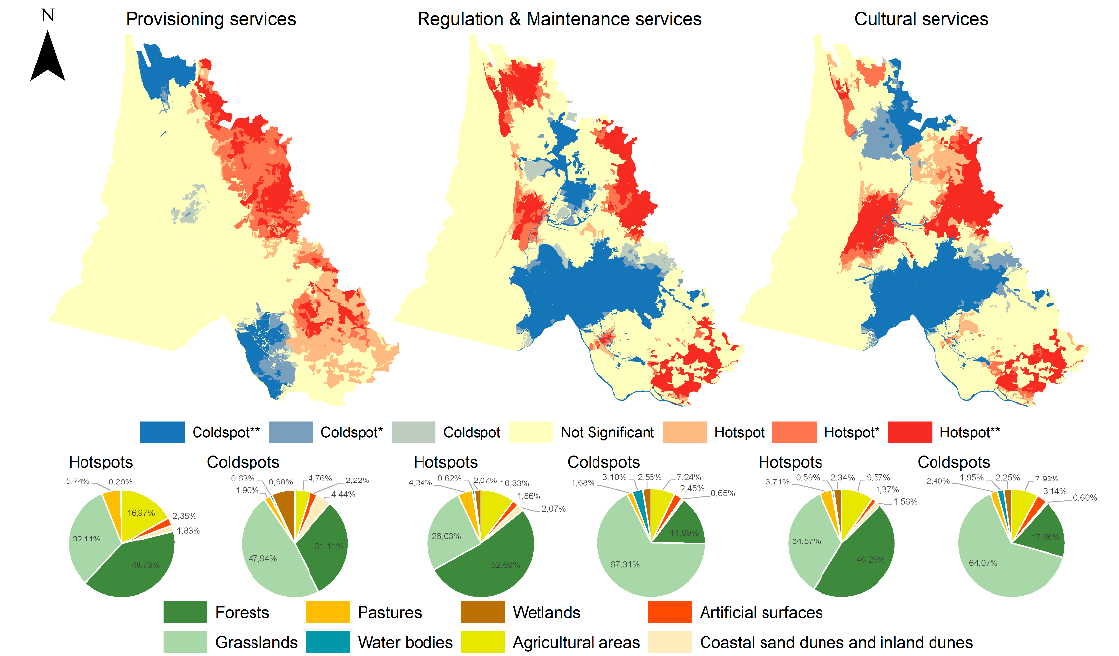
Figure 6. Hotspots and coldspots with different confidence levels. The double star (**) and single star (*) superscript indicate hotspots or coldspots that were significant at 99% and 95% level, respectively. The pie charts indicate the percentage of each CORINE/Natura 2000 land cover category from the total area of hotspots or coldspots.